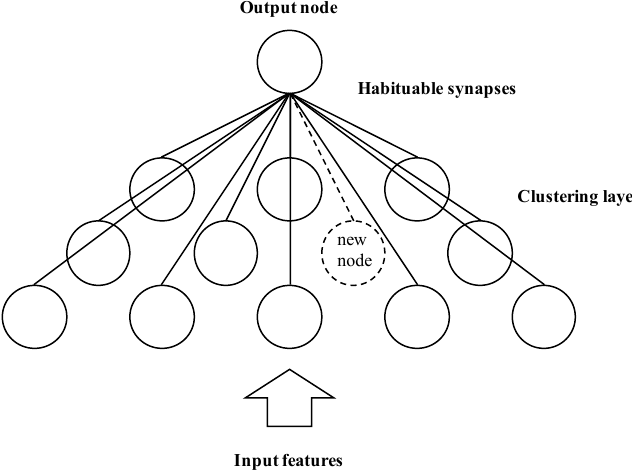
Figure 3. Graphical representation of the grow-when-required (GWR) neural network. Adaptation of the network architecture presented by Neto et al.